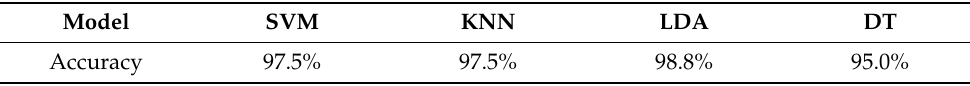
Table 3. Mean classification accuracy for various machine learning